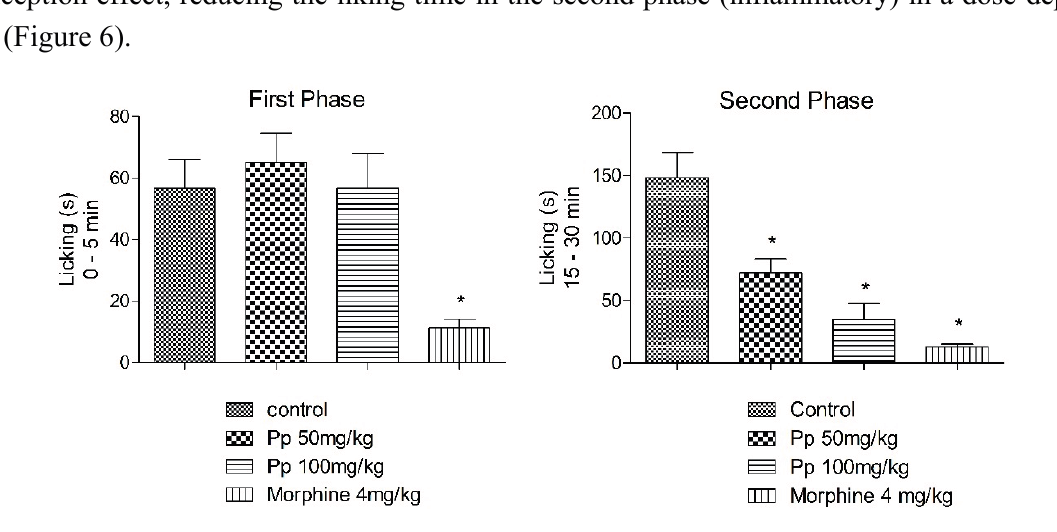
Figure 6. Formalin test: Phase 1 and Phase 2. Each group represents mean ± s.e.m. of 5 animals. * p < 0.05 when compared to the control value, F = 29.04 (ANOVA, Student-Newman Kuels’